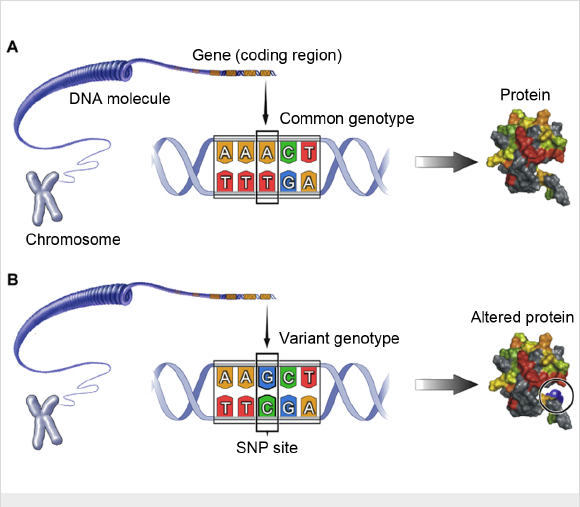
Figure 2: Single-nucleotide polymorphisms (SNPs) are genetic muta- tions that alter single base in DNA, causing sequence modification in amino acids and malfunction of a corresponding protein. Reprinted with permission from [51], copyright 2014 Elsevier.